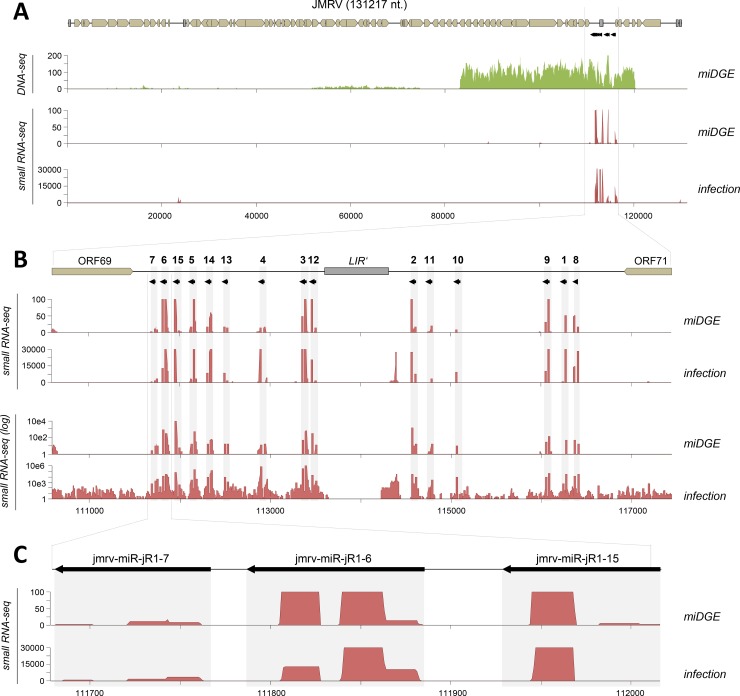
Validation of miDGE via confirmation of miRNAs encoded by Japanese Monkey Herpesvirus (JMHV).(A)
Top: Coverage plot of DNA-seq of expression fragment library containing a cosmid with ~40kb of the Japanese Monkey Herpesvirus (JMRV) genome. Center and bottom: small RNA coverage plots mapping of small RNA-seq reads from HEK293T cells transfected with the expression library (center) or from JMRV-infected rhesus primary fibroblasts (bottom). (B) Small RNA-seq coverage plot in linear (top panels) or logarithmic (bottom panels) across the miRNA-coding region. The genomic location of the 15 JMRV pre-miRNAs is indicated by black arrows at the top. (C) Detailed depiction of small RNA-seq coverage across the first three pre-miRNAs of the JMRV miRNA cluster.